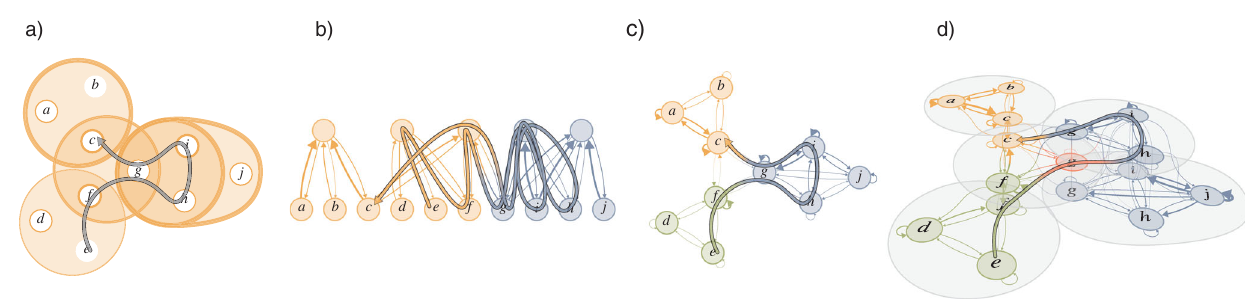
Fig. 1 A schematic hypergraph represented with three types of networks. a The schematic hypergraph with weighted hyperedges and hyperedge- dependent node weights. White circles labelled from a to j represent nodes, and large orange circles represent hyperedges incident to the nodes in each circle. Thin hyperedge borders for weight 1, medium for weight 2, and thick borders for weight 3. No node borders for node weight 1, thick borders for aggregated weights larger than 1 (Supplementary Code 1). A lazy random walk depicted with an arrow on the schematic hypergraph represented on: b a bipartite network where the unlabelled nodes represent the hyperedges, c a unipartite network and d a multilevel network with grey circles de fi ning each layer. The colours indicate optimised module assignments, in d for hyperedge-similarity walks. The links' thicknesses are proportional to the random walk ’ s transition rates.